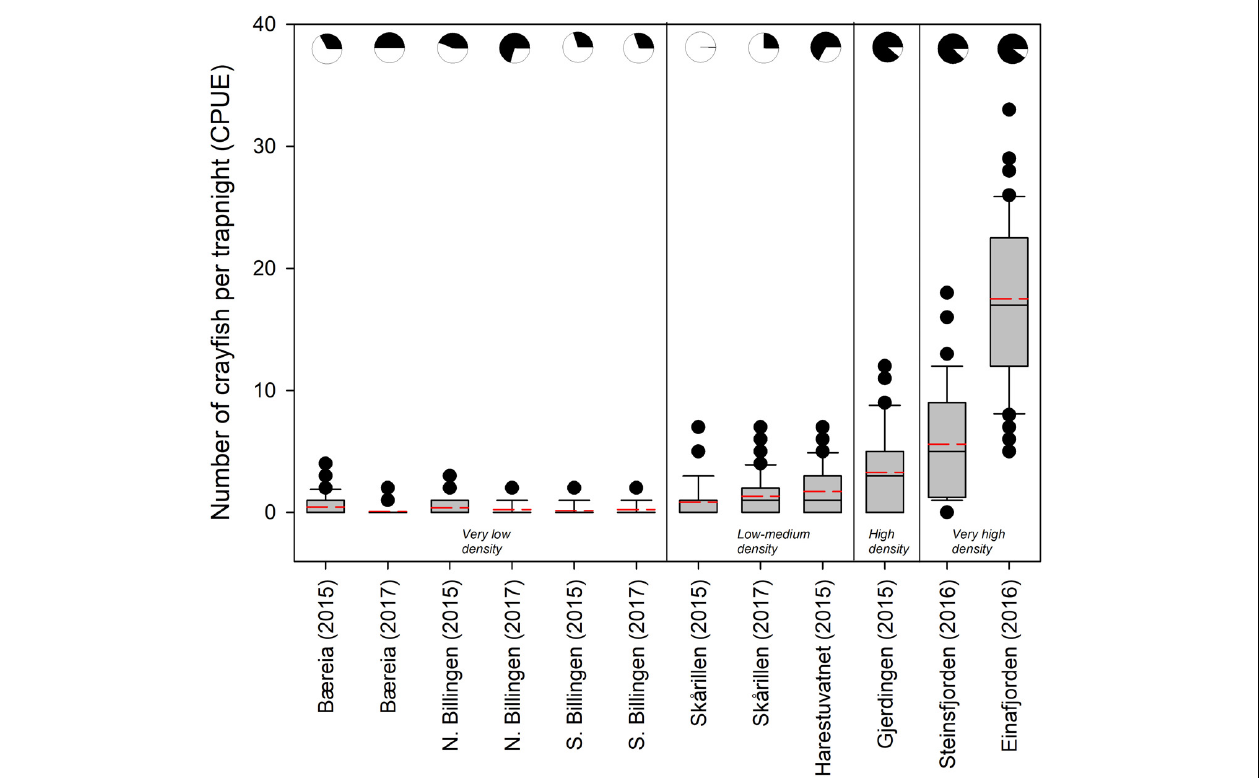
FIGURE 4 | Boxplot showing the number of noble crayfish per trapnight (CPUE) in the eight localities. The plots are based on the number of crayfish caught in the individual traps within the lake. The box contains 50% of the individual trap values, the median and the average values are shown as black and stippled red lines, respectively. The whiskers indicate the 5 and 95 percentiles and the dots ( • ) show values outside this interval. The pie charts depict the qPCR detection frequency (black part being positive) from the water samples. ddPCR detection frequency is not included. Exact values are given in Supplementary Table 1 .